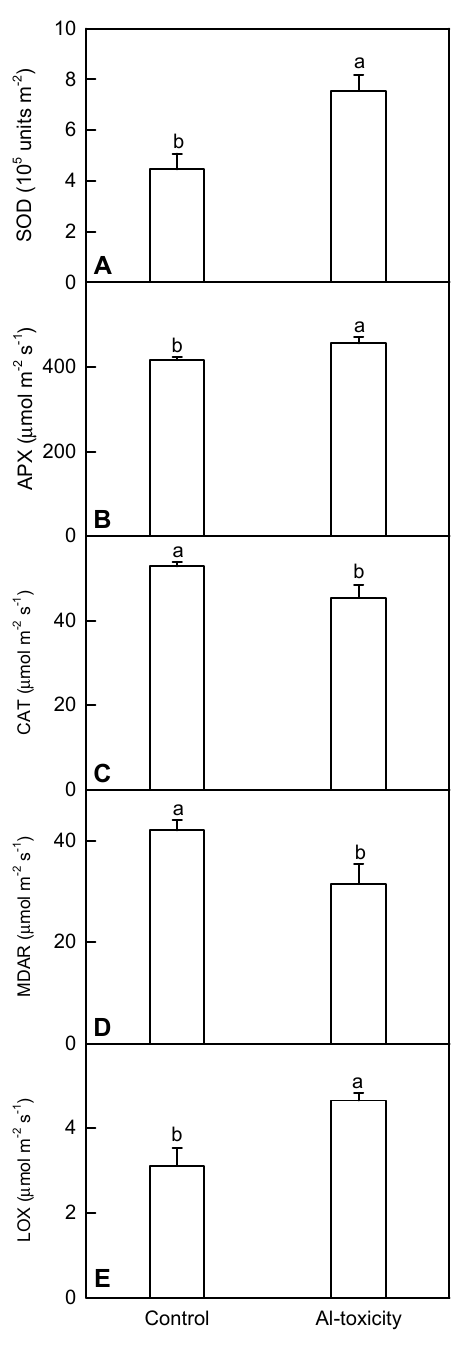
Figure 3. Effects of Al toxicity on the activities of superoxide dismutase (SOD) ( A ); ascorbate peroxidase (APX) ( B ); catalase (CAT) ( C ); monodehydroascorbate reductase (MDAR) ( D ) and lipoxygenase (LOX) ( E ) in C. sinensis leaves. Bars represent the means ± SE ( n = 4). Significance tests for two means (control and Al toxicity) were carried out by the unpaired t -test at the p < 0.05 level. Different letters above the bars indicate a significant difference at p < 0.05.